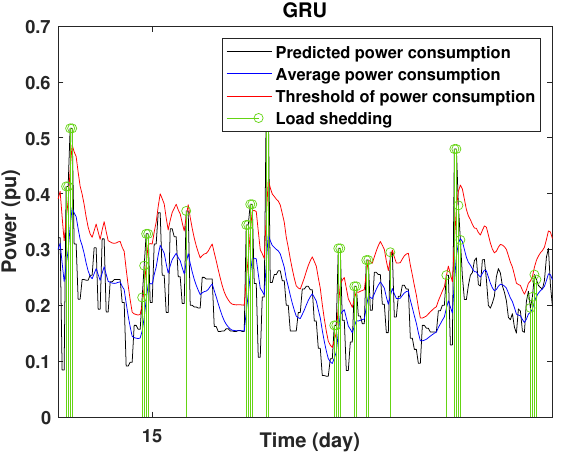
Figure 21. Detection of power consumption peaks during 1 days using the GRU model.